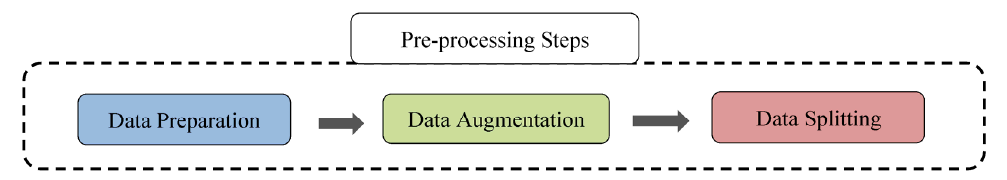
Figure 6. The pre-processing steps.